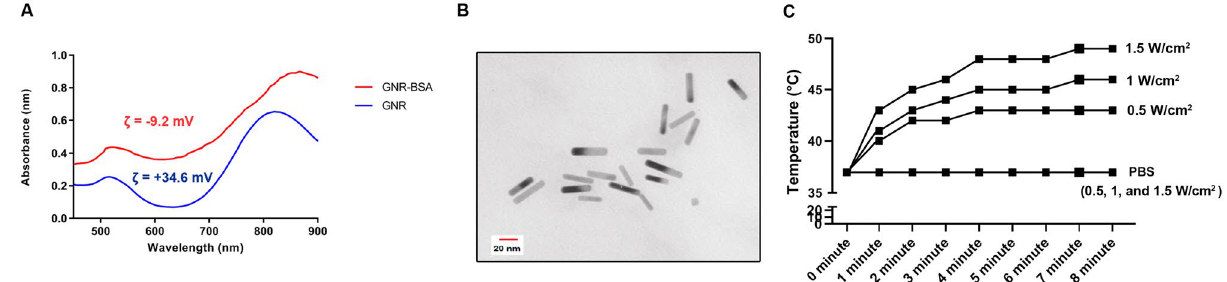
Figure 1. UV–Vis spectrum of GNRs and GNR-BSA ( A ); TEM imaging revealed rod-shaped gold nanoparticles reaching mean length and diameter of 32.1and 7.7 nm ( B ); Photothermal effects of GNR-BSA exposed to 808 nm near-infrared diode laser for 8 min at intensities of 0.5. 1, and 1.5 W/cm 2 leading to ambient temperature increase ( C